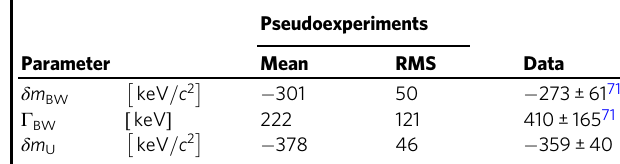
Fig. 2 Likelihood pro fi le for the g j j parameter. Likelihood pro fi le for the absolute value of the coupling constant g from the fi t to the background- subtracted D 0 D 0 π + mass spectrum with a model based on the F U signal pro fi le. Table 2 Mean and root mean square (RMS) values for the δ m Γ δ m BW , BW and U parameters obtained from pseudoexperiments produced as a consistency